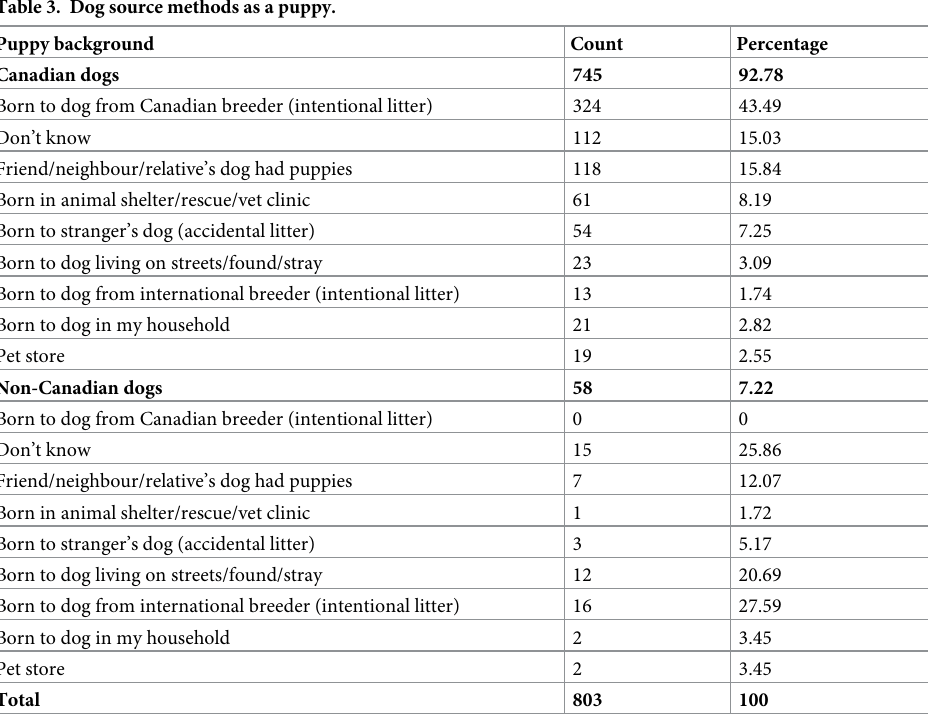
Table 3. Dog source methods as a